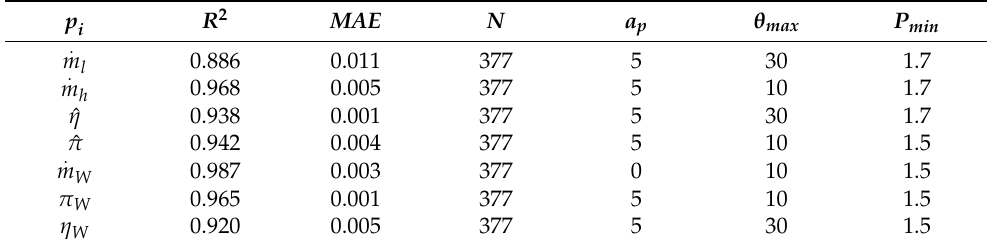
Table 2. Selected models for different performance.